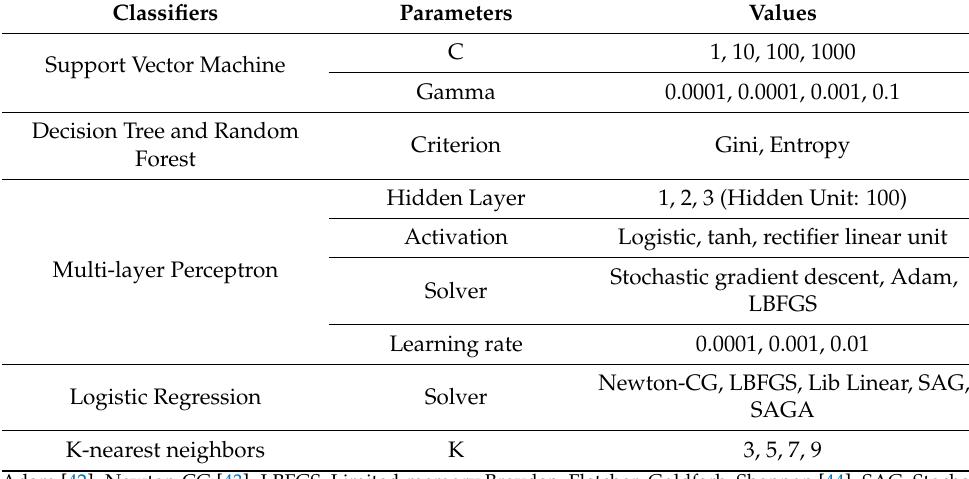
Figure 6. Grid-search cross-validation scheme with leave-one-subject-out cross-validation (each fold). This was repeated as many as the number of subjects to test all subjects.